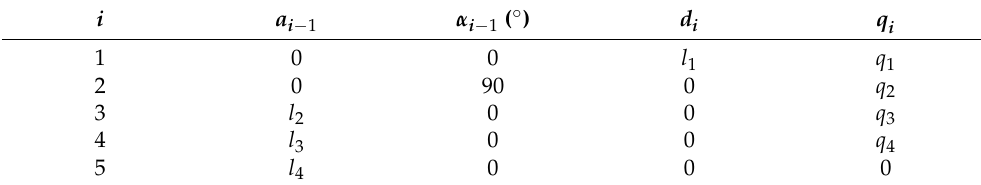
Table 1. D-H parameter.